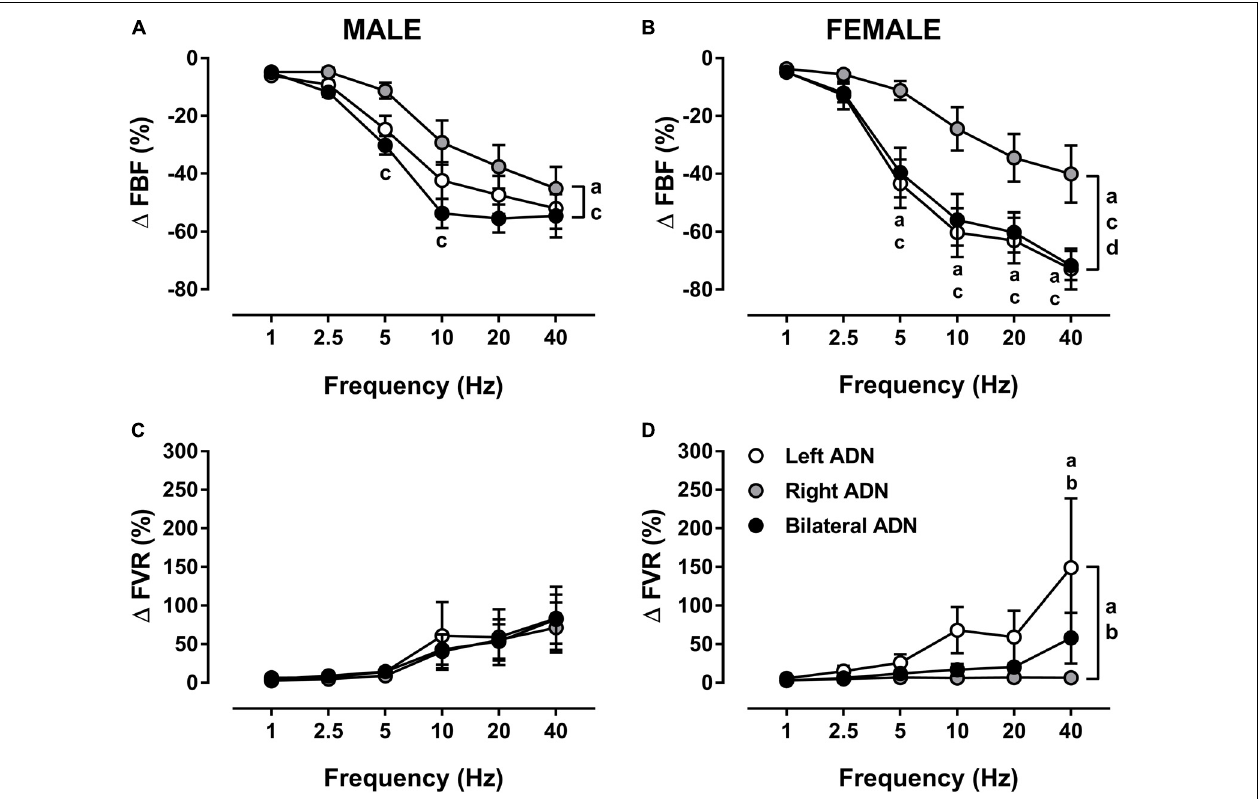
FIGURE 6 | Effects of left, right and bilateral aortic depressor nerve (ADN) stimulation (1–40 Hz, 0.4 mA, 0.2 ms, 20 s) on femoral blood flow (FBF) (A,B) and femoral vascular resistance (FVR) (C,D) responses in urethane-anesthetized male (left panels) and female (right panels) Sprague Dawley (SD) rats ( n = 7–11). Results are expressed as mean ± SEM. a P ≤ 0.05, left vs. right ADN, b P ≤ 0.05, left vs. bilateral ADN, c P ≤ 0.05, right vs. bilateral ADN and d P ≤ 0.05, female vs. male for respective left ADN analyzed by a two-way ANOVA followed by Bonferroni’s post hoc . Note that, in both males and females, left and bilateral stimulation evoked the greatest drops (both overall and variably at frequencies ranging between 5 and 40 Hz) in FBF. Reflex FVR responses did not differ in the males but, in females, measures were the highest for the left-sided stimulation (both overall and at a frequency of 40